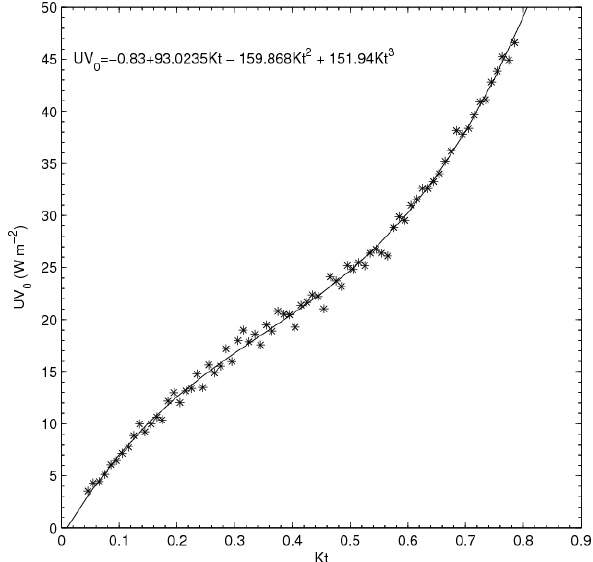
Fig. 8. Parameter UV 0 versus the clearness index ( Kt ) fitted with a cubic polynomial equation. Figure 8. Parameter UV 0 versus the clearness index (Kt) fitted with a cubic polynomial equation.